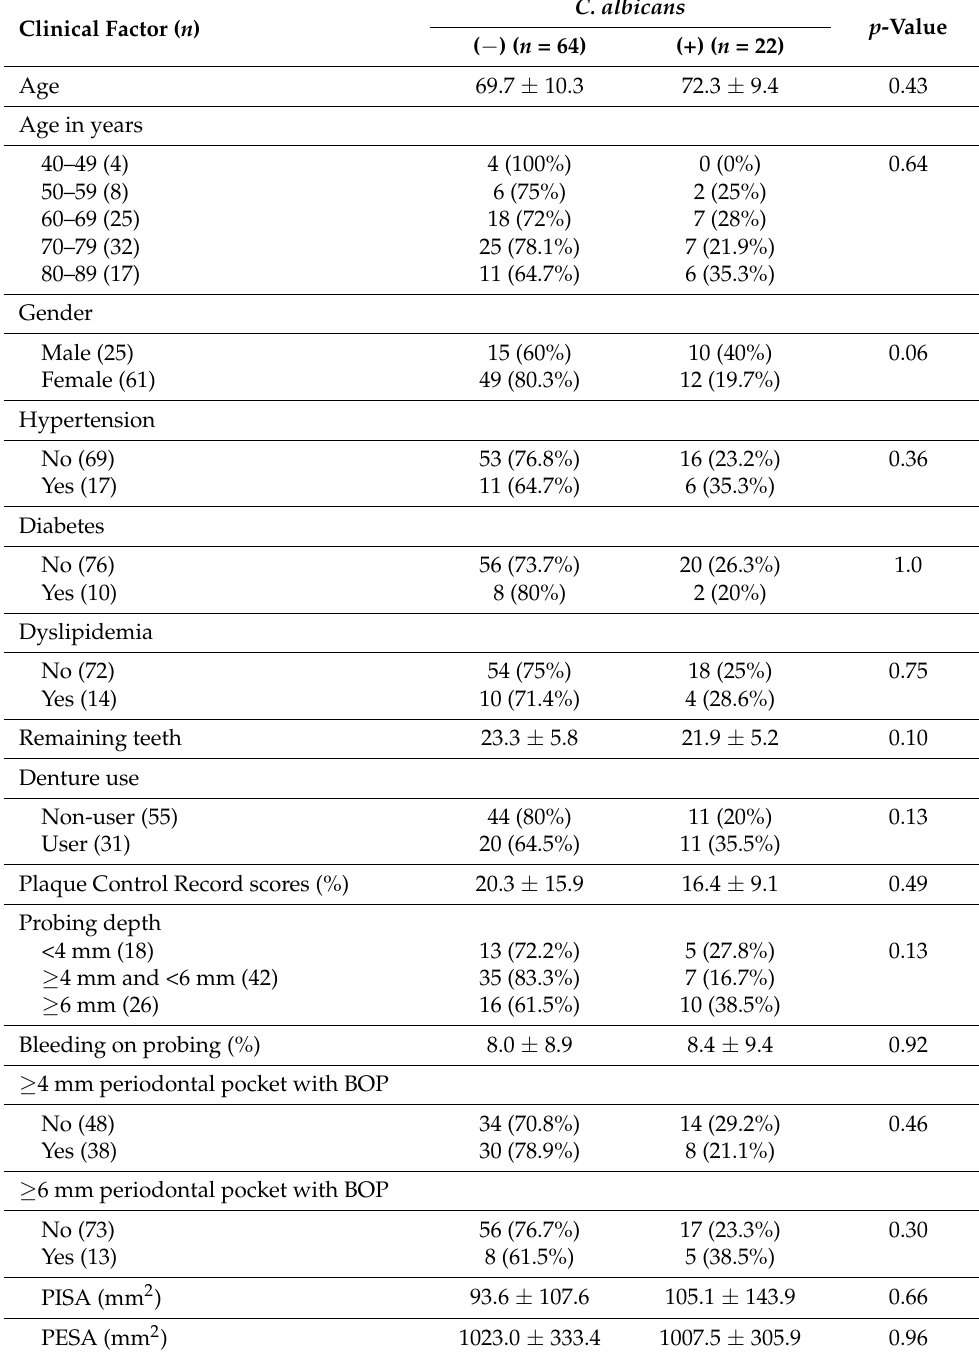
Table 1. Relationship between oral C. albicans and clinical